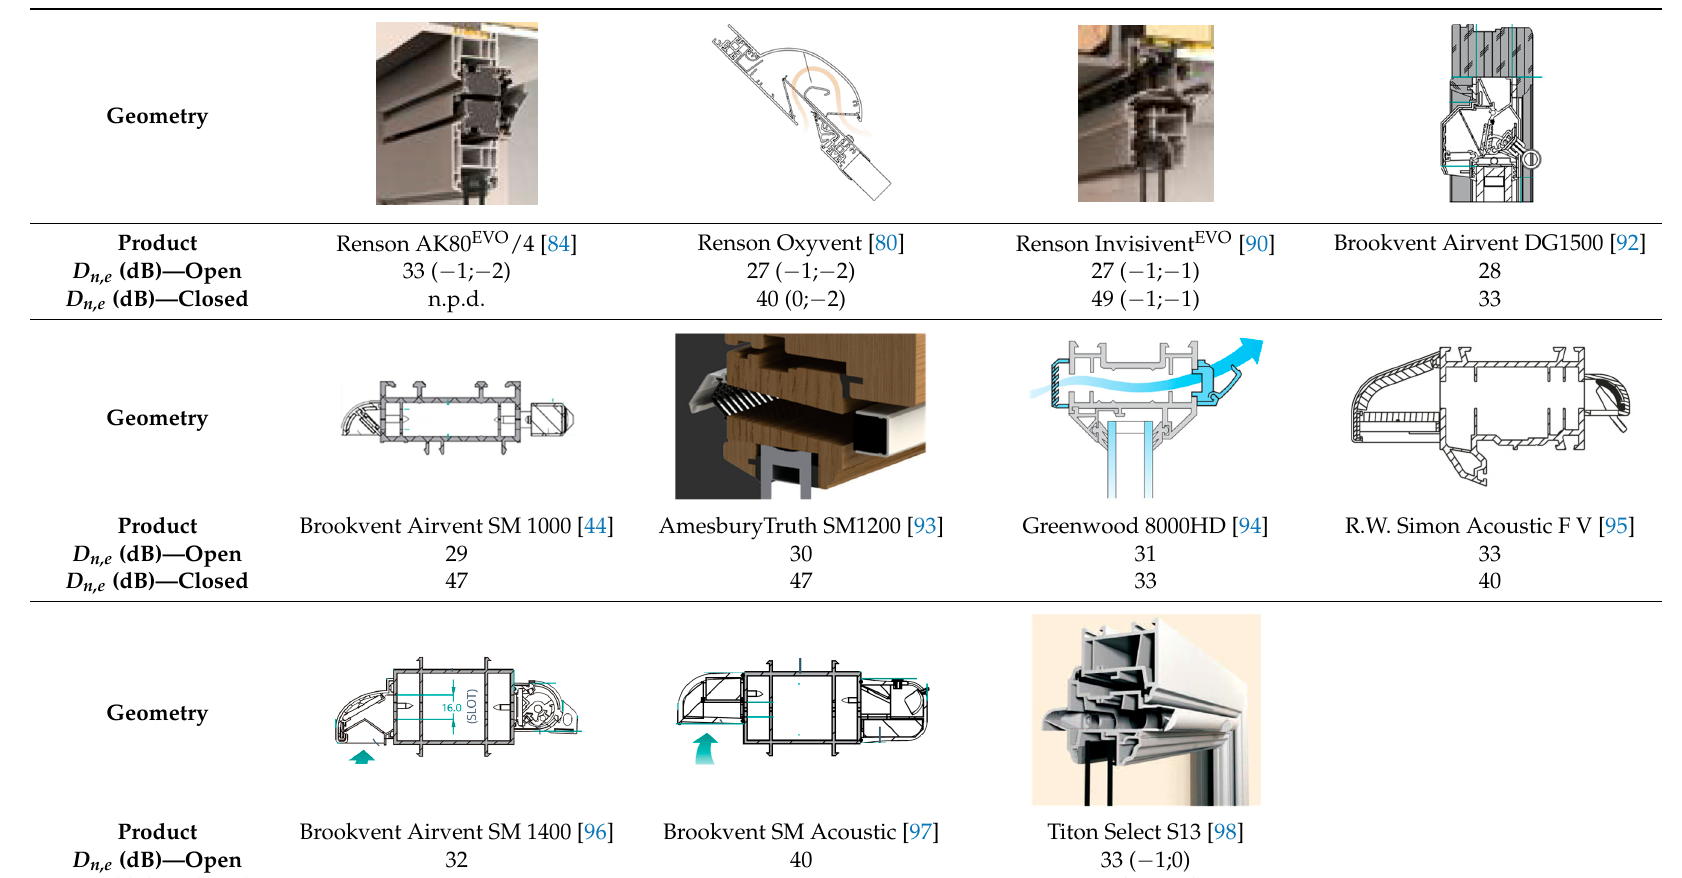
Table 9. D n,e values of various Trickle Vent products.